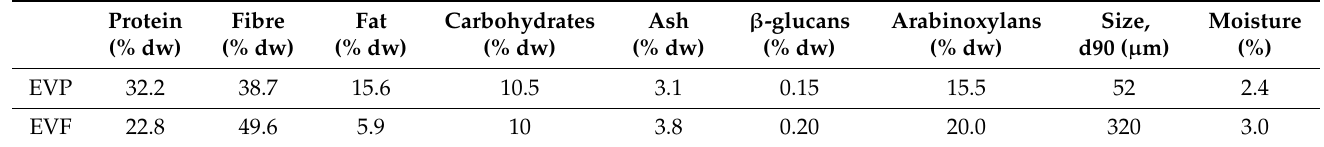
Table 1. Composition (dry weight, d.w.) of EVP and EVF